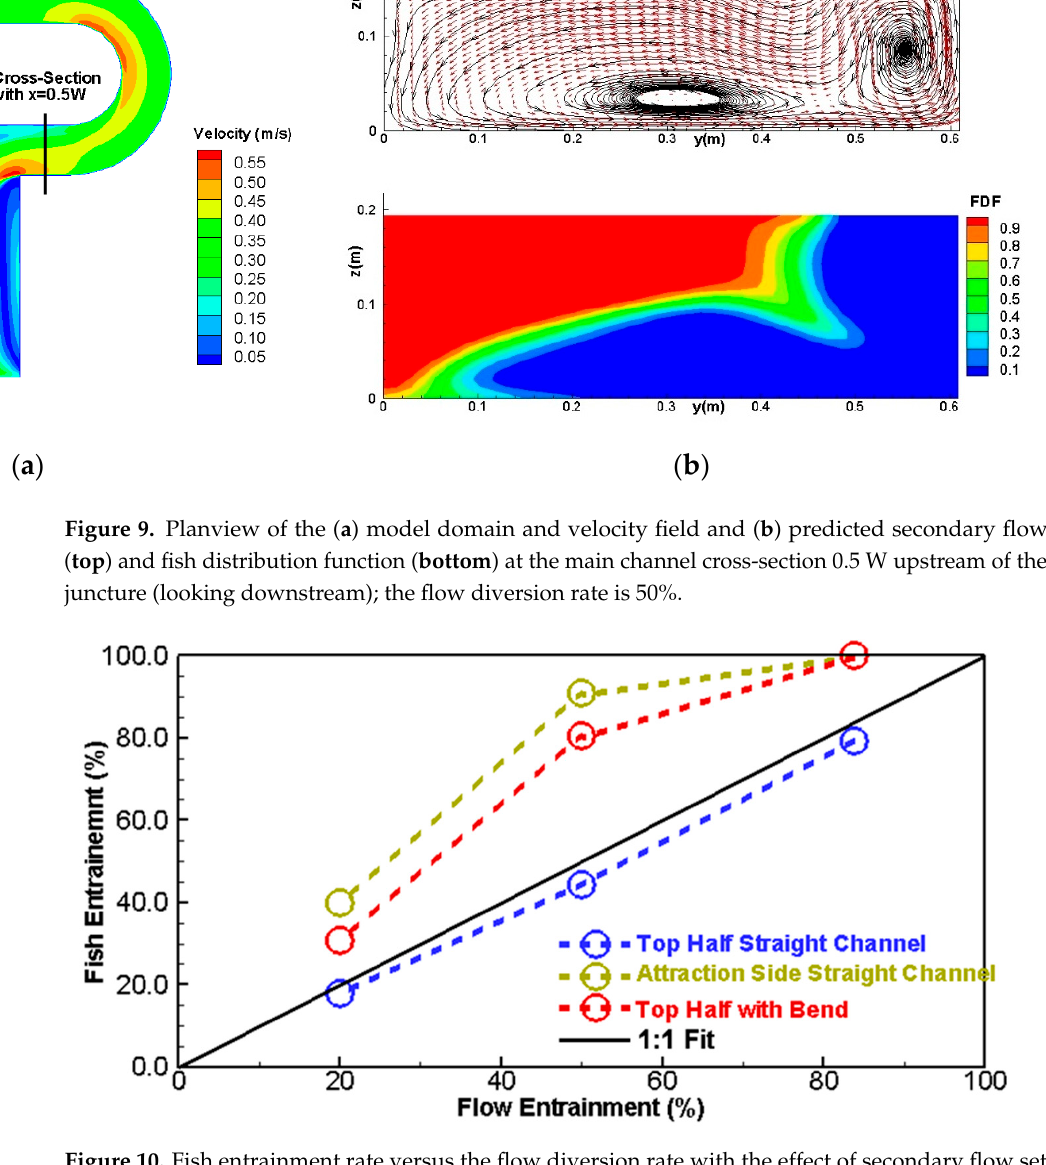
Figure 10. Fish entrainment rate versus the flow diversion rate with the effect of secondary flow set up by the 180-deg bend and the top-half fish distribution.